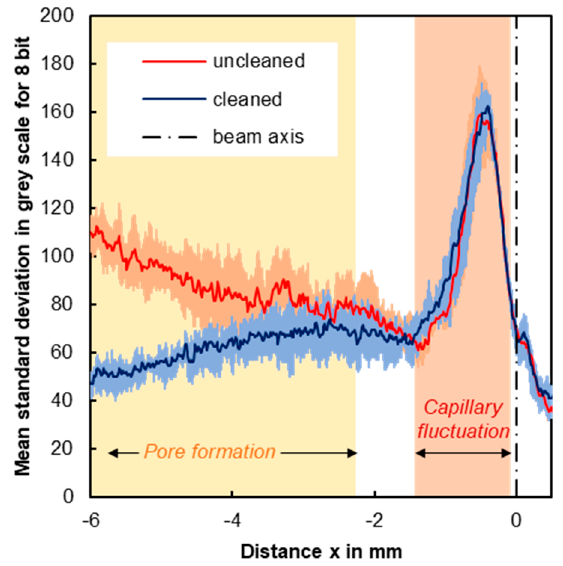
Figure 6. Mean standard deviation of the greyscale of the X-ray videos of welds welded with a feed rate of 6 m/min, a beam diameter of about 500 µm, and a laser power of 4.5 kW in overlap configuration of uncleaned sheets (red) and of sheets cleaned by etching (blue).